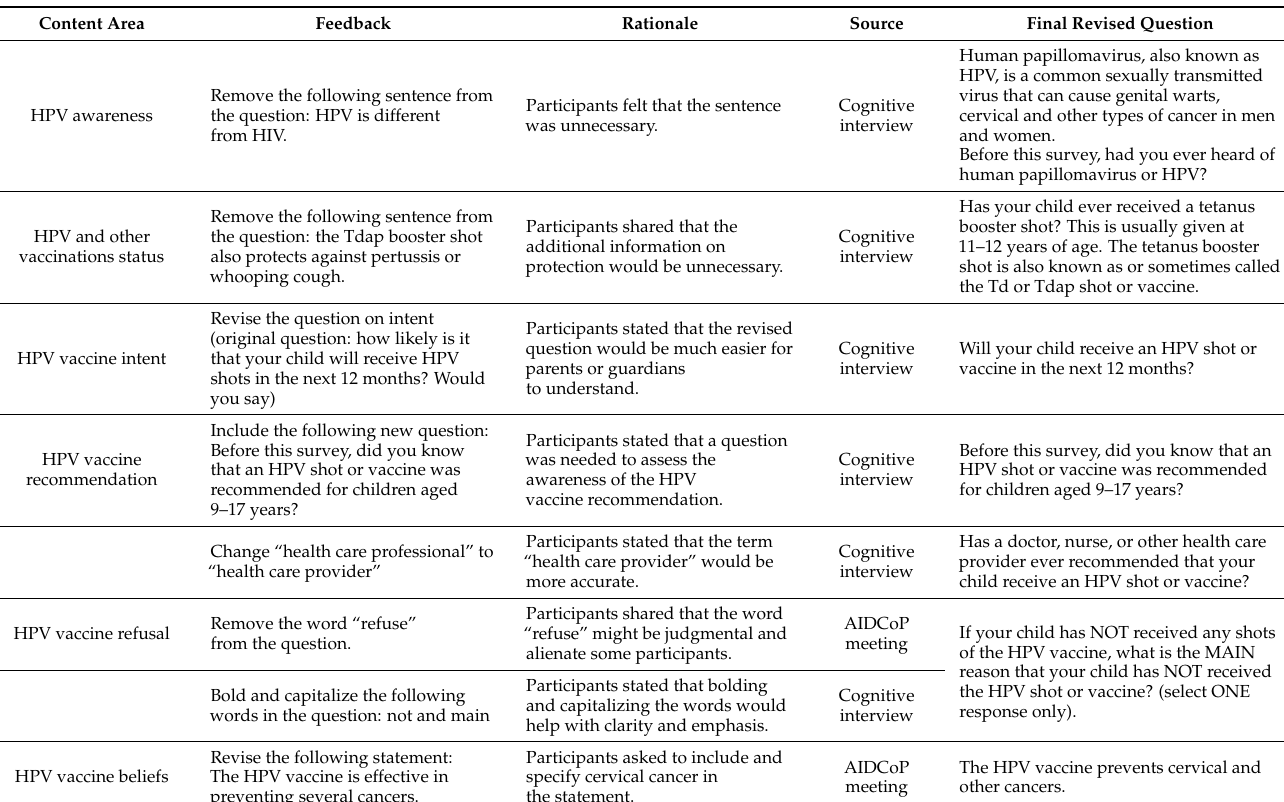
Table 1. Examples of select revisions to survey questions based on